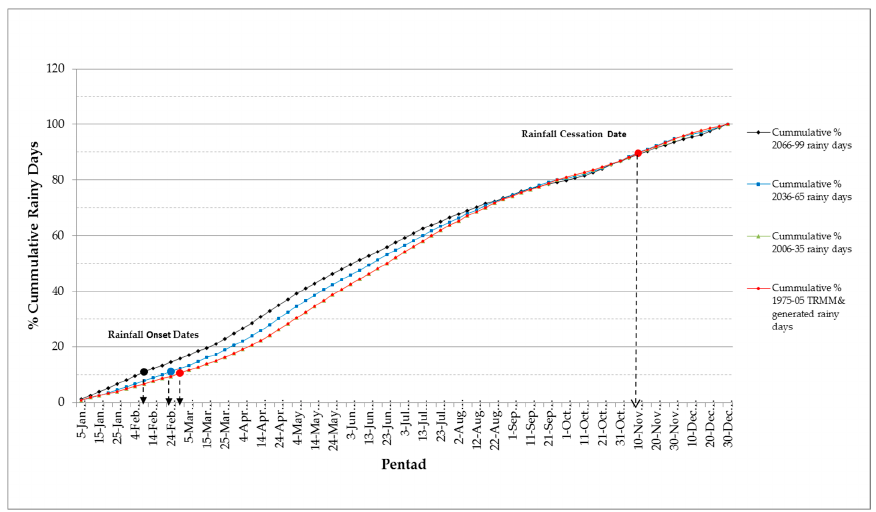
Figure 7. Agago Future Mean Rainfall Onset and Cessation for Rainy Days (TRMM Rainfall (1975–2005)